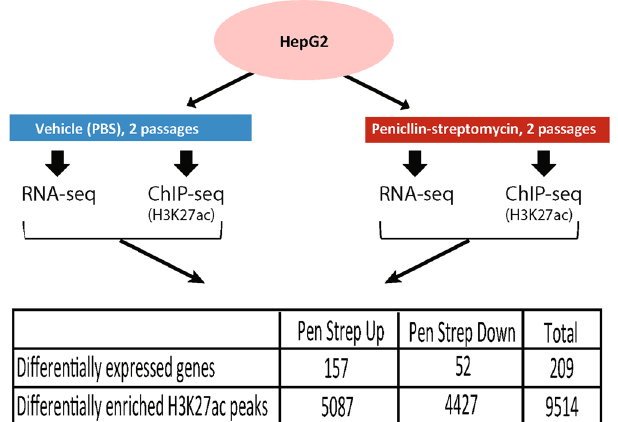
Figure 1. Experimental design. Schematic of the RNA-seq and ChIP-seq assays performed on HepG2 cells treated with and without PenStrep. The number of differentially expressed genes and differentially enriched H3K27ac peaks are listed in the table below the